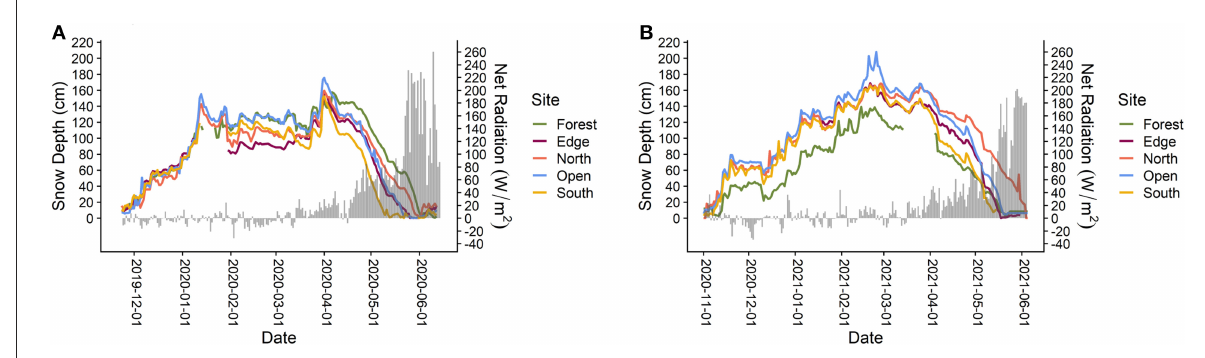
FIGURE3 Snow depth with net total radiation at the BT location during winter 2020 (A) and winter 2021 (B). Net total radiation was measured at the weather station located in an open canopy cover site.